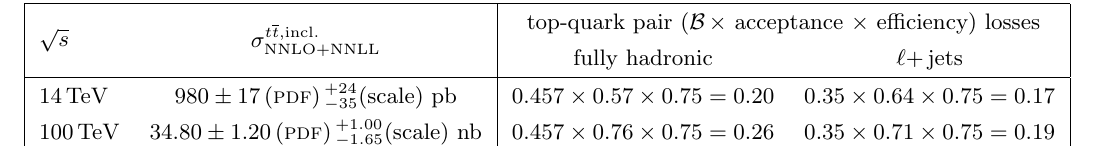
Table 5 . Top-pair cross sections computed at NNLO+NNLL accuracy with Top++ v2.0, and product of branching ratios (cid:2) acceptance (cid:2) e(cid:14)ciency losses for the fully-hadronic and ‘ + jets (with ‘ (cid:6) = e (cid:6) ; (cid:22) (cid:6) ) (cid:12)nal states (for the selection criteria listed in sections 3.1.1 and 3.1.2 respectively, computed with MadGraph5 aMC@NLO ), in pp collisions at